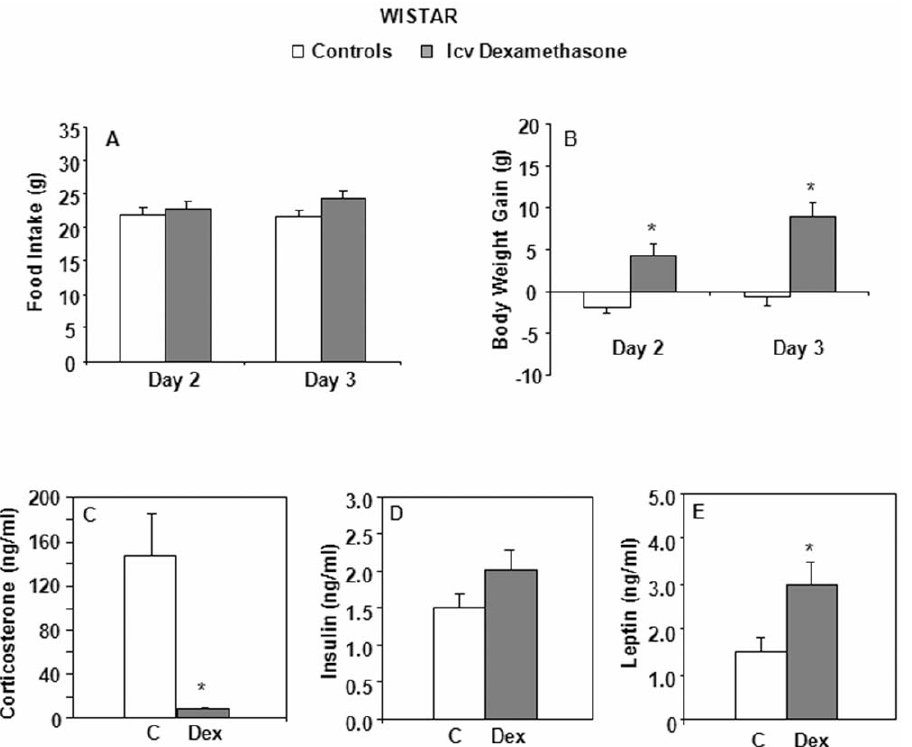
Figure 1. Food intake, body weight gain, plasma corticosterone, insulin and leptin levels of Wistar rats. Central (icv) dexamethasone infusion for 3 days. A) Results are expressed as food ingested (in grams) during the last two days of icv infusion. B) Results represent body weight gain (in grams) measured after 2 and 3 days of icv infusion. C to E) Plasma levels of corticosterone, insulin and leptin. Mean 6 SEM of n =7 rats per group. * P , 0.05 compared to vehicle-infused control rats (Student’s t test and Mann-Whitney test).